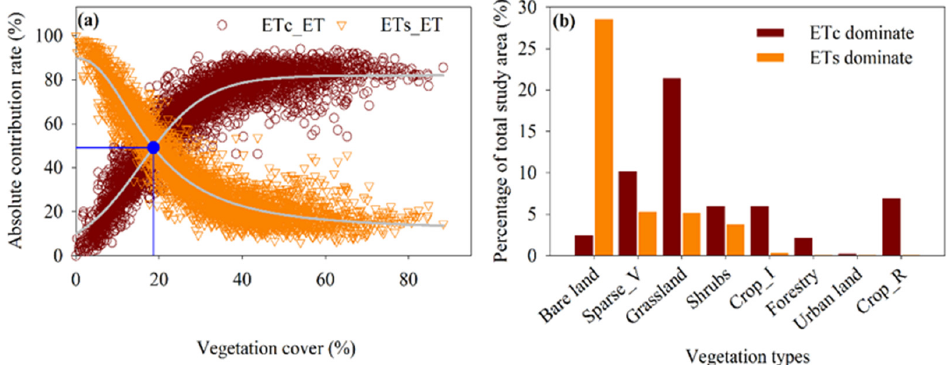
Figure 5. Contribution rate (%) of ET C and ET S to ET from 2000 to 2020. ( a ) Contribution rate of ET C and ET S to ET along the vegetation cover gradient. ( b ) Percentage of area where ET C and ET S dominate ET variation in the total study area under different vegetation types. In panel ( b ), the crop I and crop R represent the irrigated and rain-fed croplands, respectively, and sparse V indicates sparse vegetation.